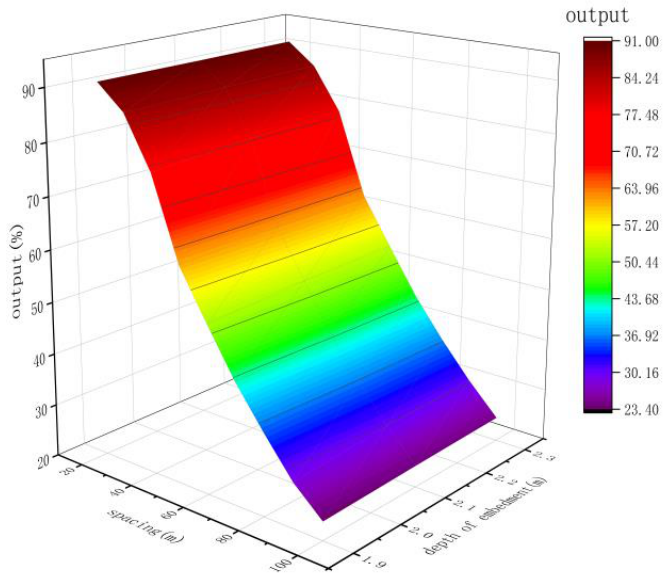
Figure 6. Simulation results of the cotton yield under natural conditions.